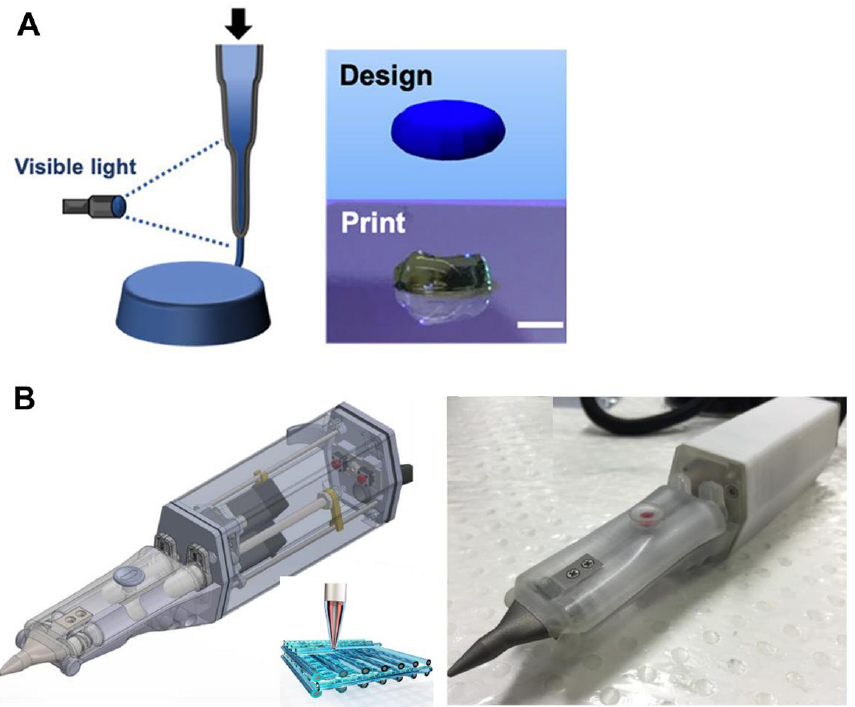
Figure 8. In situ bioprinting techniques: ( A ) In situ crosslinking technique consisting of exposing the bio-ink to visible light just after being extruded. Adapted from [66]. ( B ) “Biopen”—extrusion-based handled bioprinting technique based on a coaxial system. Adapted from [67]. Gelatin methacrylate (GelMA) has also been widely applied in cartilage regeneration via 3D bioprinting due to its desirable fast crosslinking using UV light, together with its biodegradability, biocompatibility, and limited antigenicity. Ruiz-Cantu et al. [68] used extrusion-based bioprinting to manufacture porous scaffolds using a GelMA bio-ink with ovine chondrocytes. GelMA, as a cell carrier, proved to be good in terms of high cell via- bility and proliferation after bioprinting. In addition, cells also managed to produce GAGs and collagen. Despite the fact that mechanical properties increased after bioprinting, they did not achieve native cartilage values. Consequently, the authors proposed the addition of PCL through 3D printing as a mechanical support. The hybrid GelMA – PCL scaffold showed the same ability to maintain good cell viability (Figure 9A) and chondrogenic functionality after bioprinting. Interestingly, the mechanical properties strongly in- creased, suggesting the use of hybrid scaffolds as a cartilage regeneration strategy [68]. A similar approach was performed by de Ruijter et al. [69] In this case, the scaffold bi- oprinted by extrusion, and composed of GelMA and equine MSCs, was reinforced with PCL fibers using a melt electrowriting technique. This electrospinning technology uses a high-voltage electrical field to form sub-micrometer fibers from polymer melts. The au- thors showed that the inclusion of this technique had no negative effects on cell viability and proliferation. In fact, cells maintained the ability to produce GAGs and collagen after bioprinting. Therefore, as Figure 9B shows, the inclusion of PCL with this technique may be a good option to increase the mechanical properties of scaffolds for cartilage regenera- tion [69].